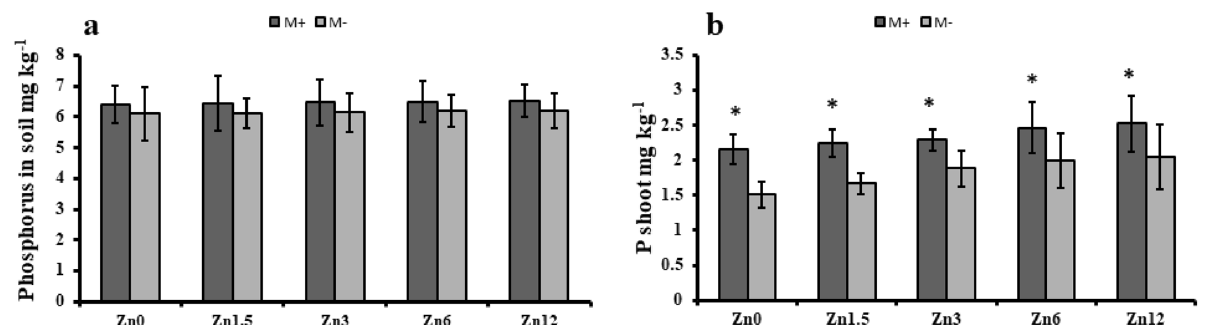
Figure 6. Effect of arbuscular mycorrhizal inoculation on Phosphorus contents of maize under zinc deficient soil conditions. ( a ) phosphorus concentration in soil (mg kg −1 ) (b) phosphorus concentration shoot (mg kg −1 ). Zn -1 -1 ), Zn -1 ), Zn -1 ), inoculated with AMF ), Zn 3 (3 mg kg 0 (control), Zn 1.5 (1.5 mg Kg 6 (6 mg kg 12 (12 mg kg (M + grey), un-inoculated (M- white). Error bars represent standard error and asterisk (*) shows significant difference ( p ≤ 0.05) among treatments (Zn × AMF